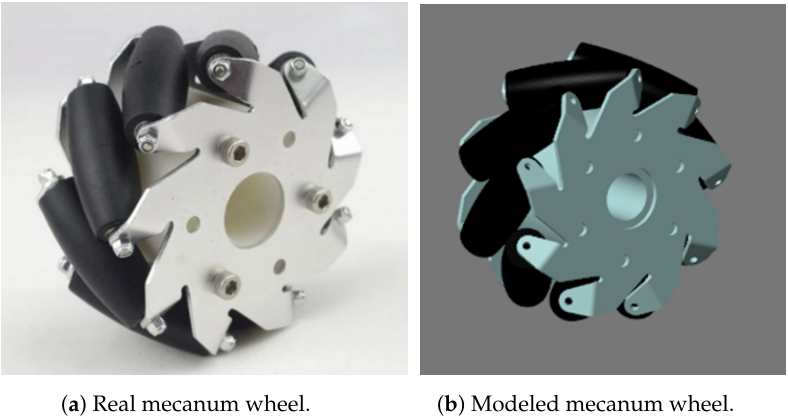
Figure 5. Mecanum wheel: real and modeled.